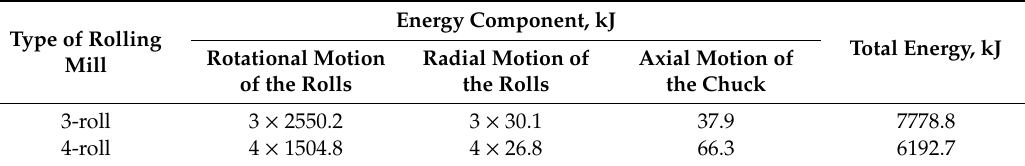
Table 2. Energy required to form hollow